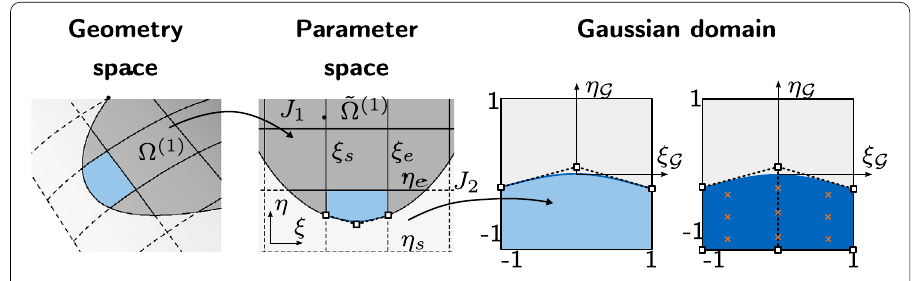
Fig. 7 AGIP integration procedure: sub domain of (cid:7) (1) (blue) in the Geometryspace and in the Parameter space with a segment of the refined trimming curve. Mapped sub domain and trimming curve in the Gaussiandomain and auxiliary NURBS surface for the integration